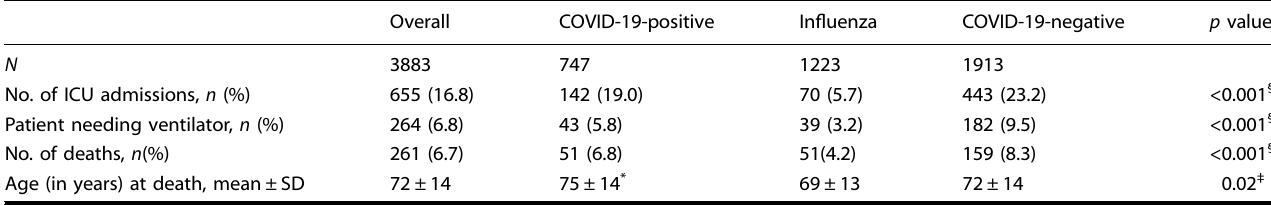
Table 2. Outcomes of WVU patients presented at ED or admitted to WVU hospitals and tested positive for COVID-19, positive for in fl uenza A/B or negative for